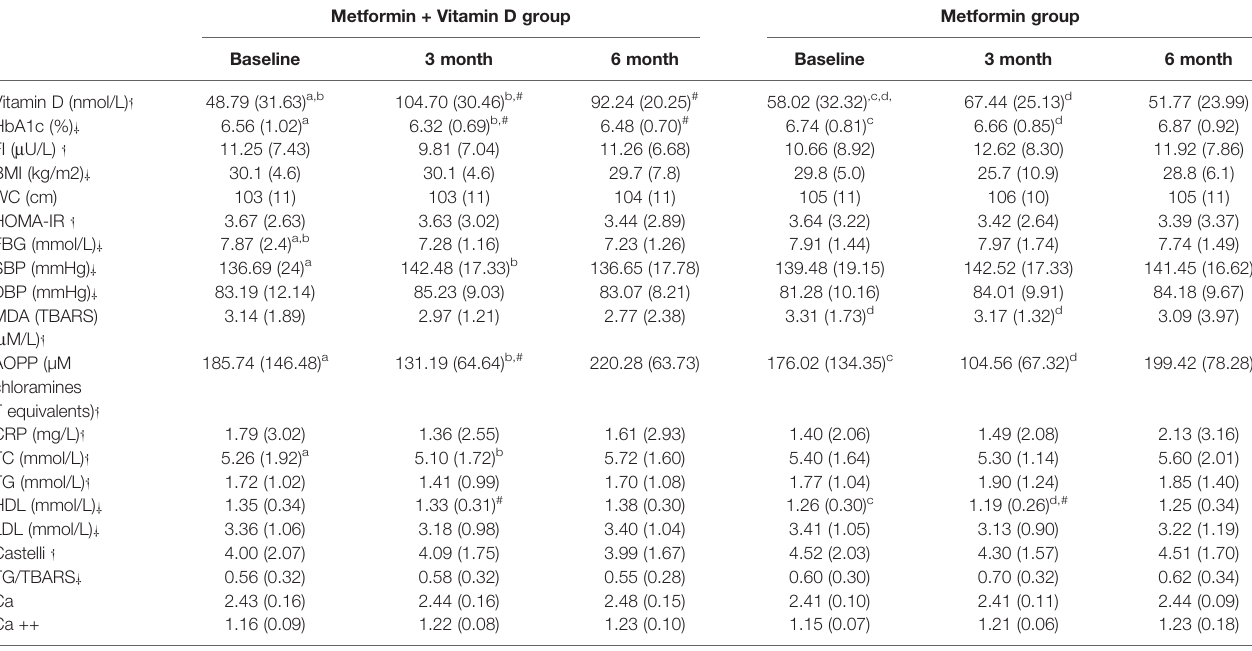
TABLE 2 | Comparison of measured parameters over the 6-month period of vitamin D treatment. Metformin + Vitamin D